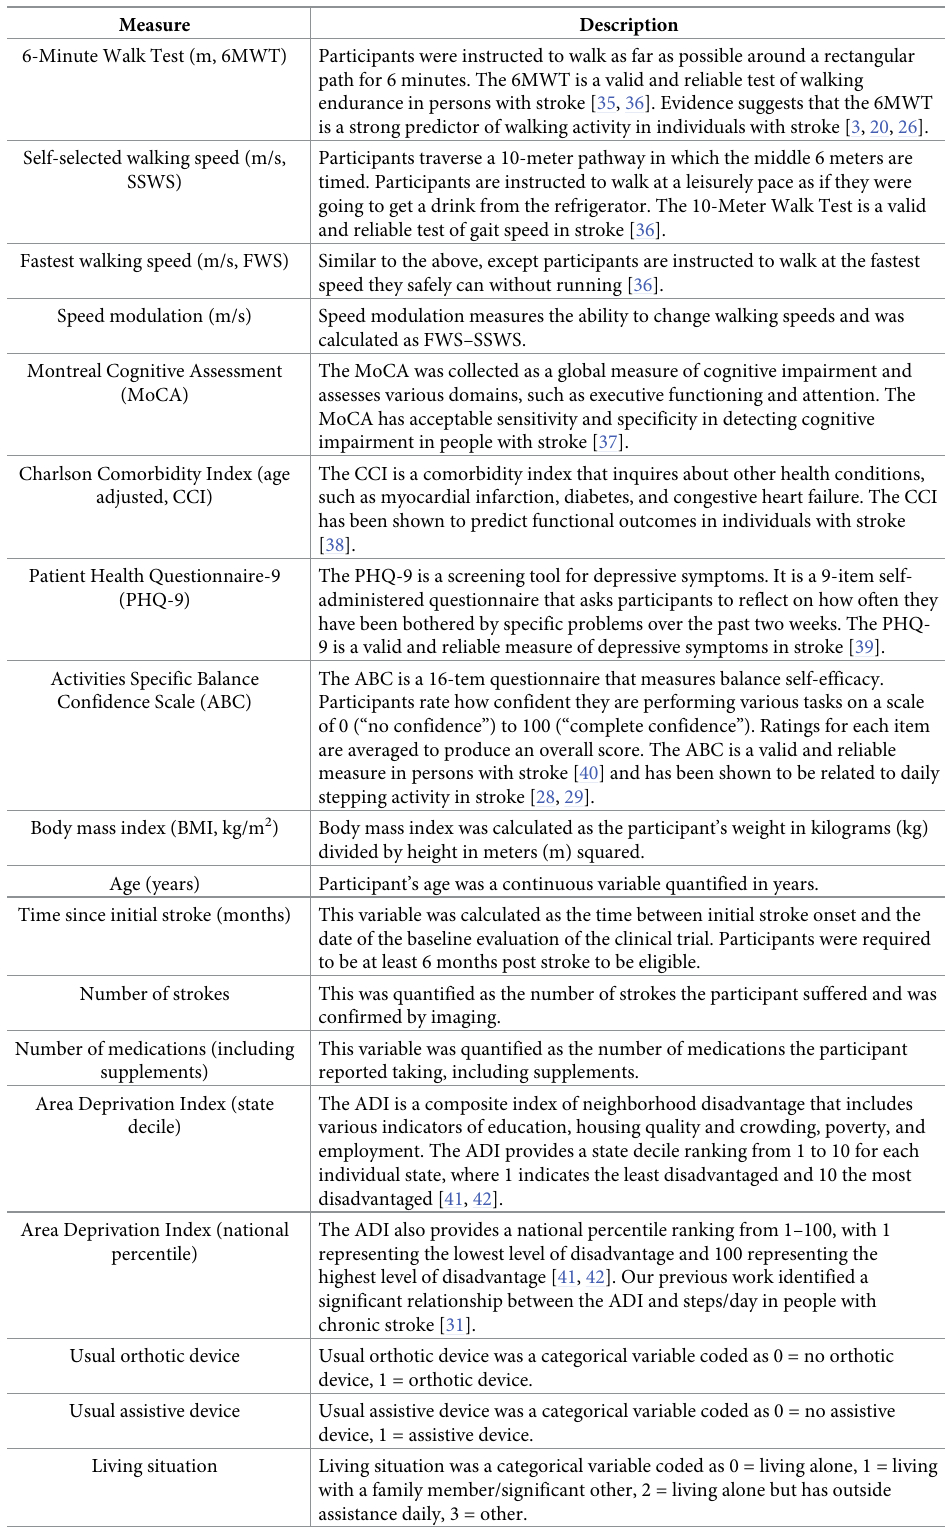
Table 2. Description of